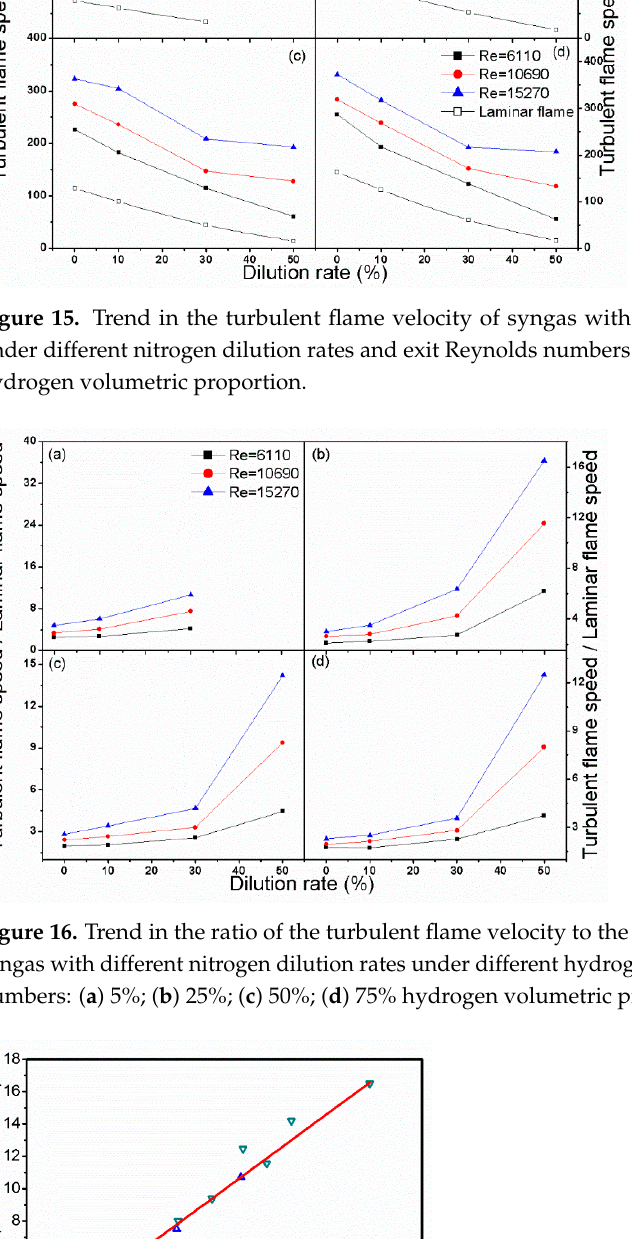
Figure 18. Relationship between the winkled rate and the ratio of turbulent flame velocity to laminar flame velocity under different flame conditions: ( a ) nitrogen dilution volumetric proportion of 10%, Re = 10,690, different hydrogen proportion in fuel; ( b ) hydrogen volumetric rate of 50%, Re = 10,690, different nitrogen dilution; ( c ) nitrogen dilution volumetric proportion of 10%, hydrogen volumetric ratio of 50%, different Reynolds number. 4. Conclusions In this paper, the combustion characteristics of a turbulent premixed flame with dif- ferent proportions of hydrogen and carbon monoxide, and different nitrogen dilution rates and exit Reynolds numbers were investigated. The results showed that the increase in the hydrogen proportion contributed to the formation of the OH radical in the flame, increased the burning velocity, and decreased the flame size under a certain outlet Reyn- olds number. As the dilution of syngas increased, the concentration of the OH radical decreased and the flame size enlarged due to the weakening of combustion intensity. By comparing different Reynolds numbers at the exit, the effect of turbulence intensity on the flame was mainly focused on the structure of the flame front surface. The higher turbu- lence intensity led to more complicated folds of the flame front surface, which enhanced the combustion intensity. For the same fuel, higher turbulence intensity increased the OH concentration to some extent and reduced the size of the flame surface. The instantaneous OH distribution of the syngas jet flame was obtained by an OH- PLIF experiment. The flame front surface and the turbulent flame velocities of different